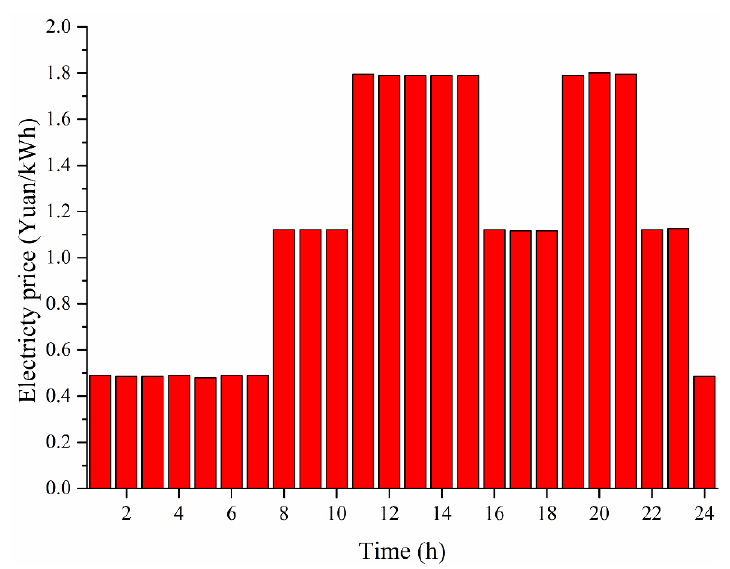
Figure 8. Time-of-use power price.